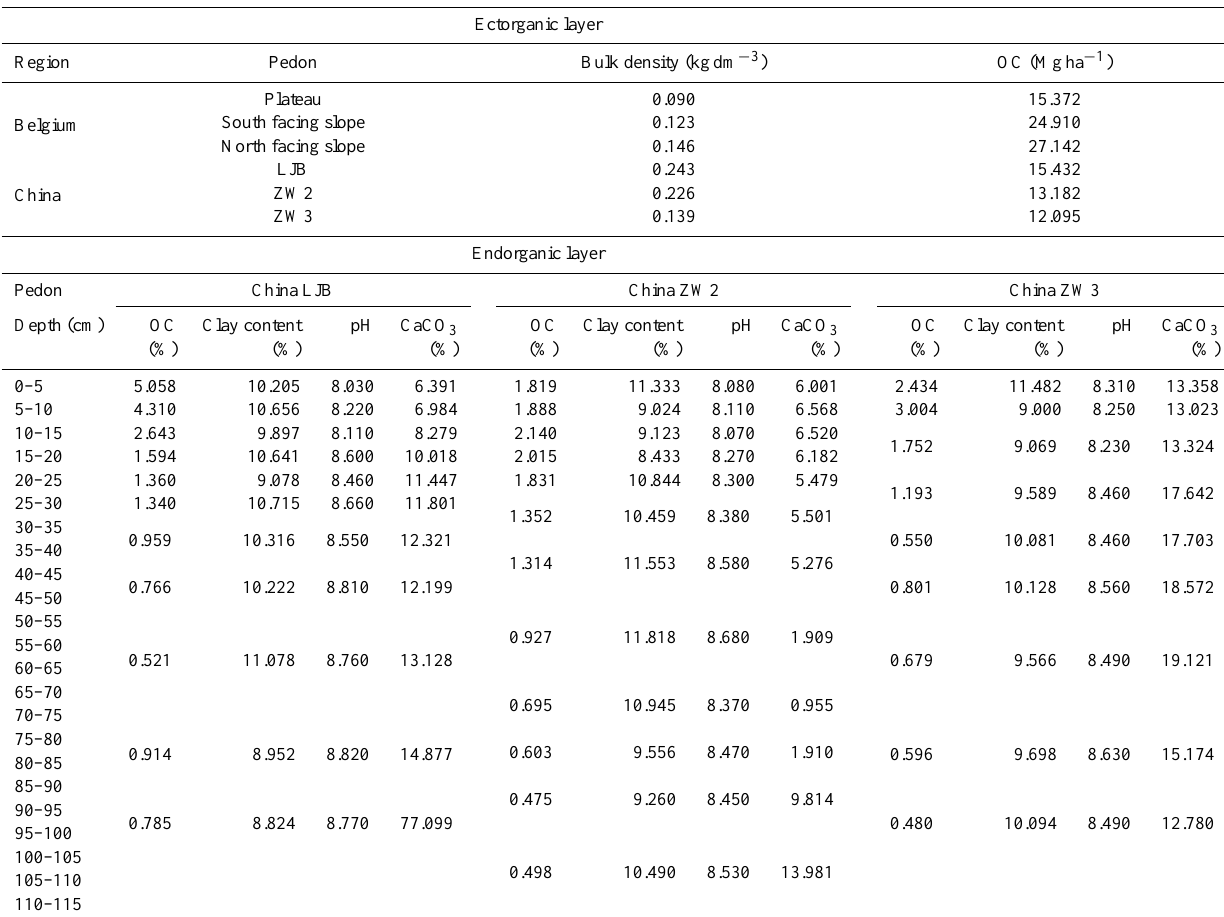
Table 1. Selected analytical results of ectorganic and endorganic layers in Belgian and Chinese pedons. Results for endorganic layers of Belgian pedons were published in Finke